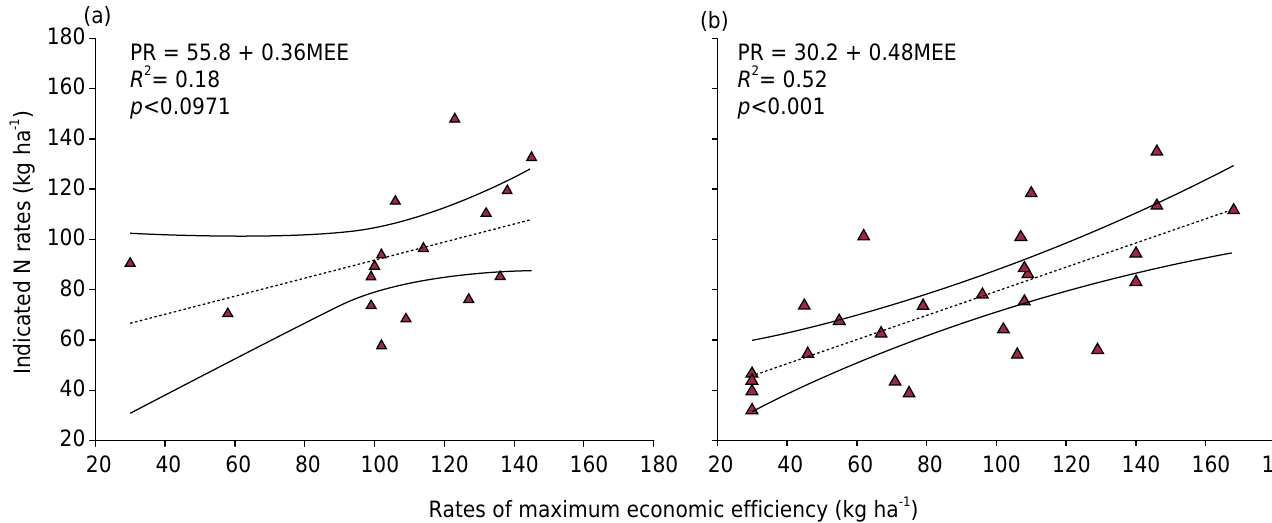
Figure 7. Relationship of maximum economic efficiency rates and urea-N rates indicated for wheat (a) and barley (b) in the South- Central region of Paraná. Dotted lines represent linear regression curves and solid lines 95 % of the confidence